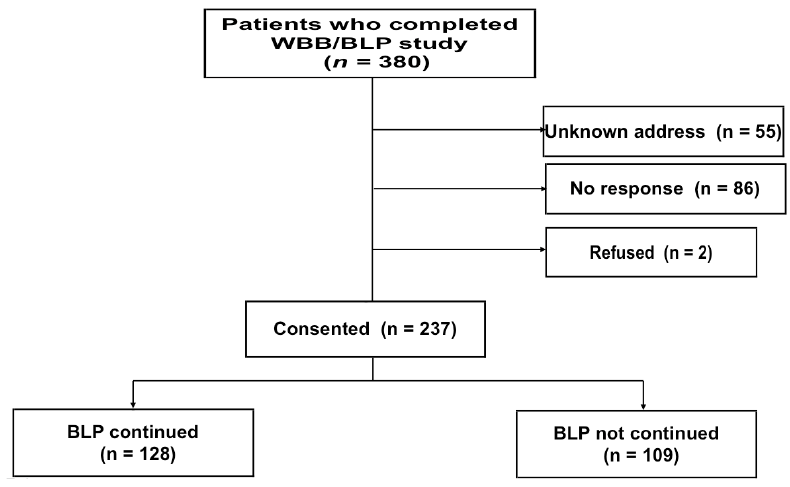
Figure 1. Flowchart of study entry.